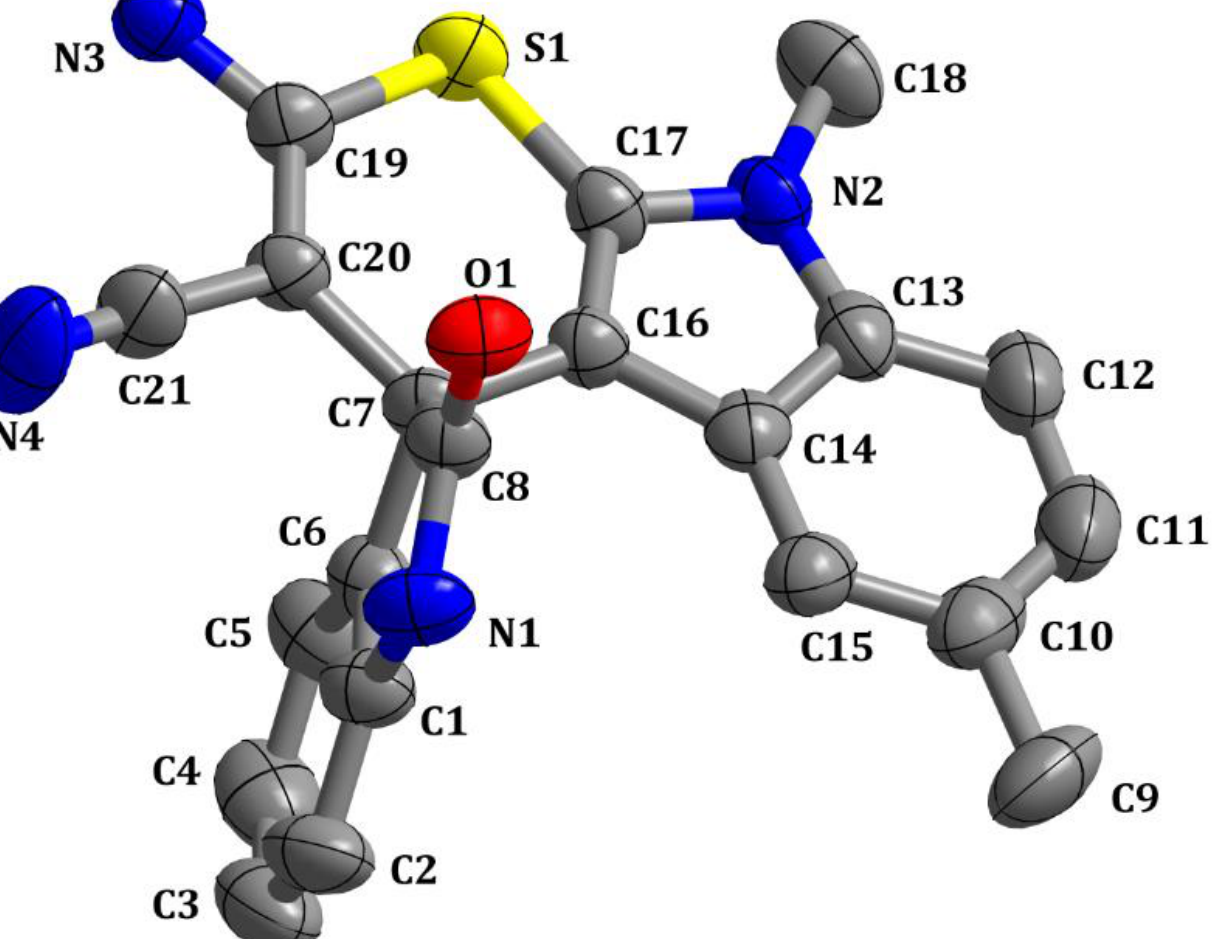
Figure 1. Crystal structures of 3g (CCDC 2177975) detected by Bruker APEX-II CCD (the thermal ellipsoids are drawn at a 30% probability